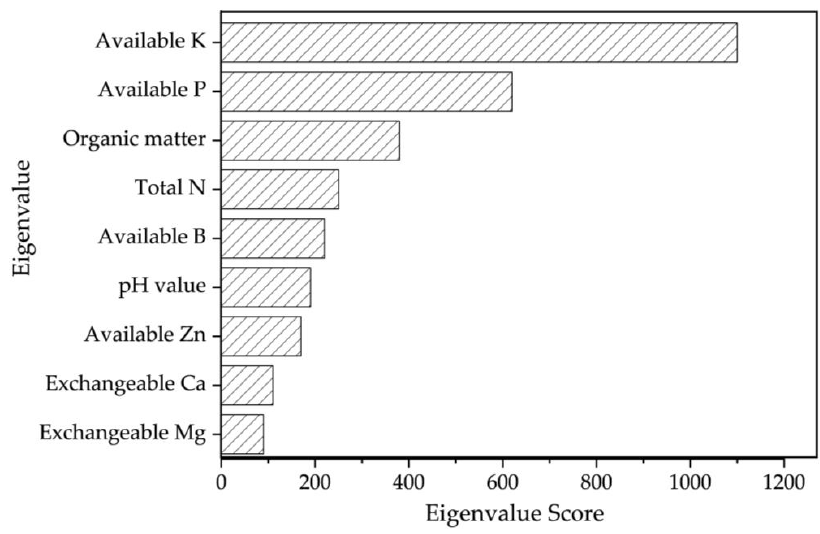
Figure 5. Eigenvalue score of LightGBM model.